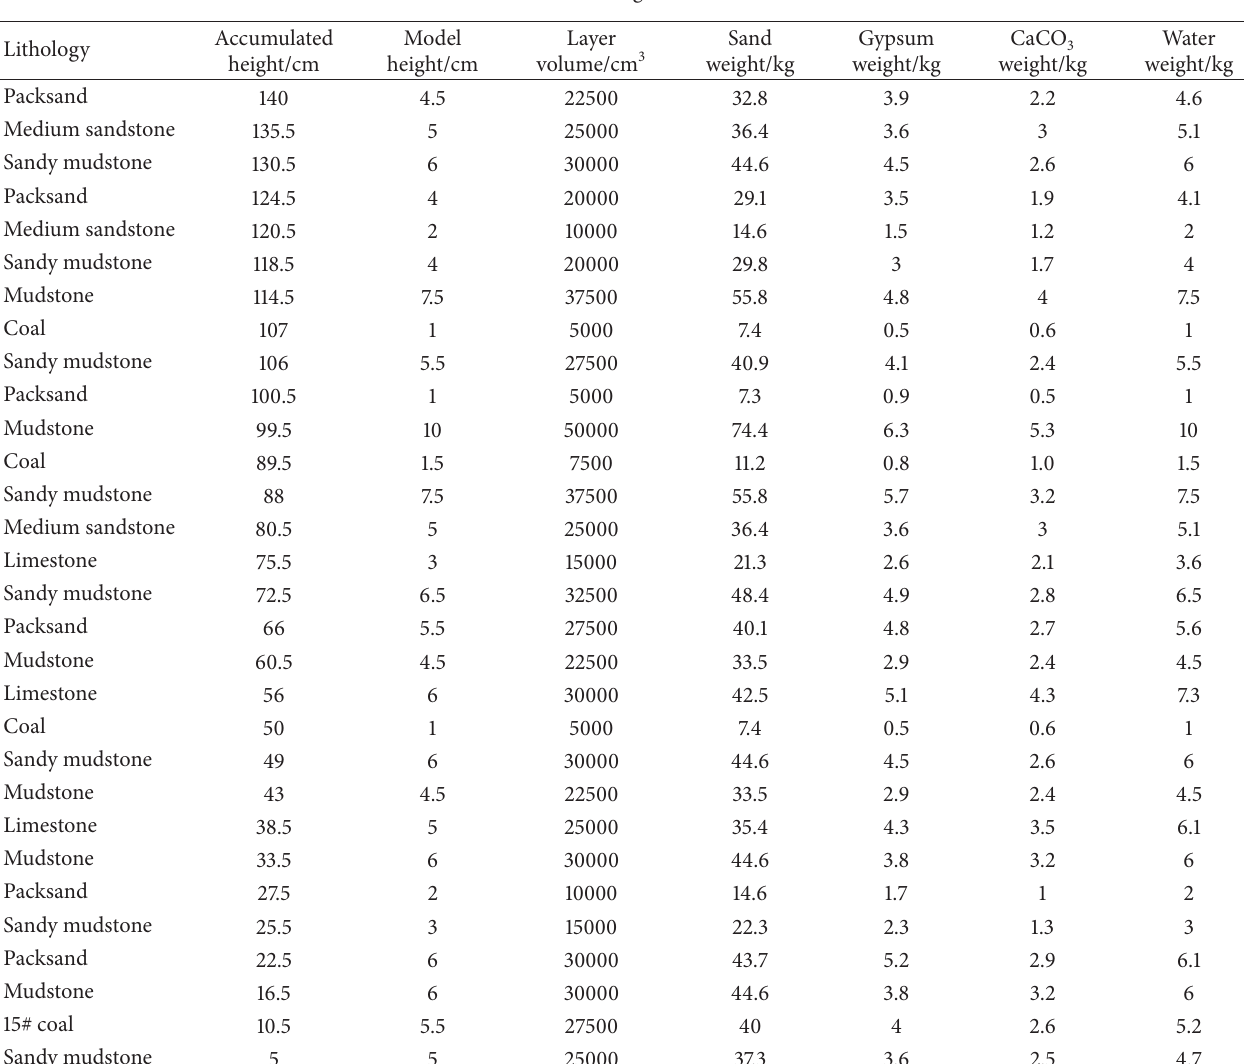
Table 2: Modelling material